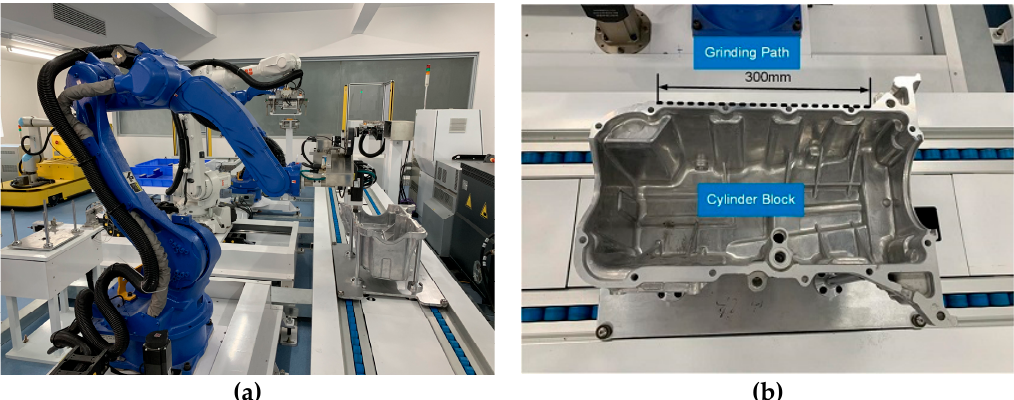
Figure 11. Experimental device diagram of the free form surface grinding robots(FFSGRs) ( a ) and engine cylinder block grinded in experiments ( b ).